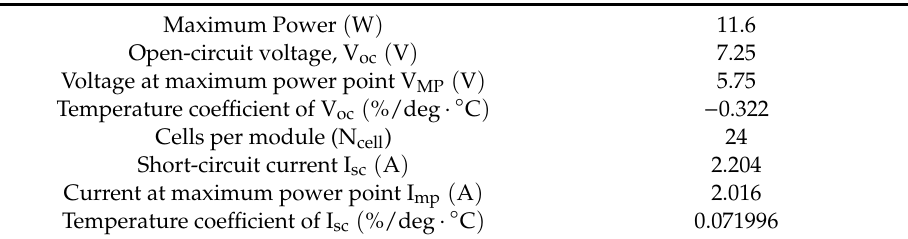
Table 1. Operational characteristics of each PV module.